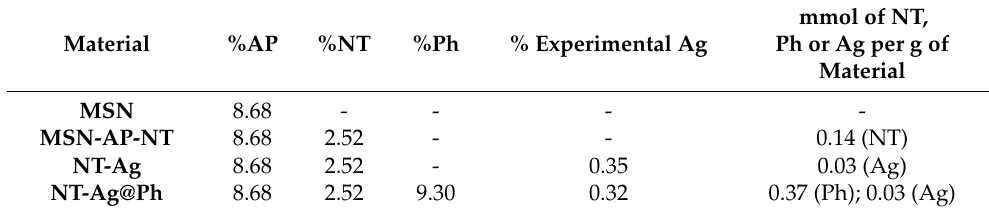
Table 2. Weight percentage and functionalization/encapsulation ratio of AP, NT, Ph, and Ag in the materials